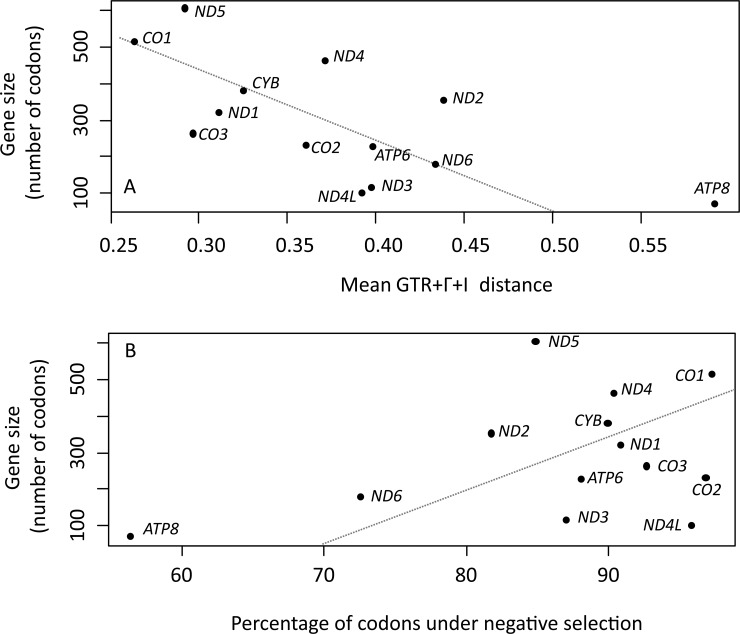
Gene size, genetic distance and codons under negative selection.(A) Significant, positive correlation between mitochondrial gene size and mean GTR+Γ+I distance (r2 = 0. 461; p = 0.011). (B) Non-significant, negative correlation between gene size and percentage of codons under negative selection (r2 = 0.136; p = 0.214).